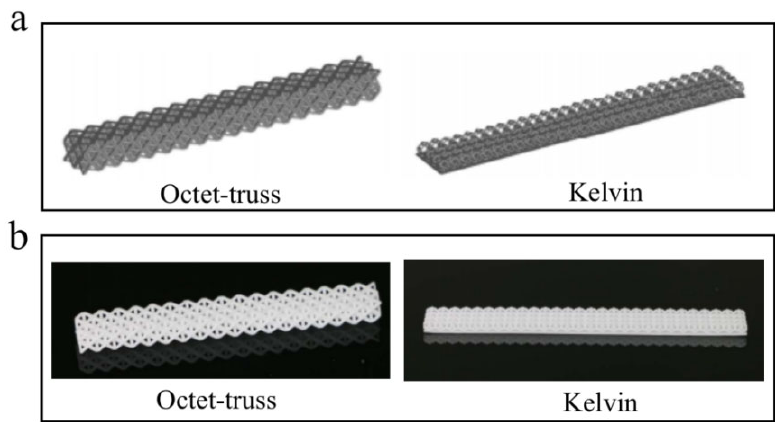
Fig. 43 (a) 3D models with different structures; (b) ZrO 2 ceramic cellular structures. Reproduced with permission from Ref. [119], © The Author(s) 2019.